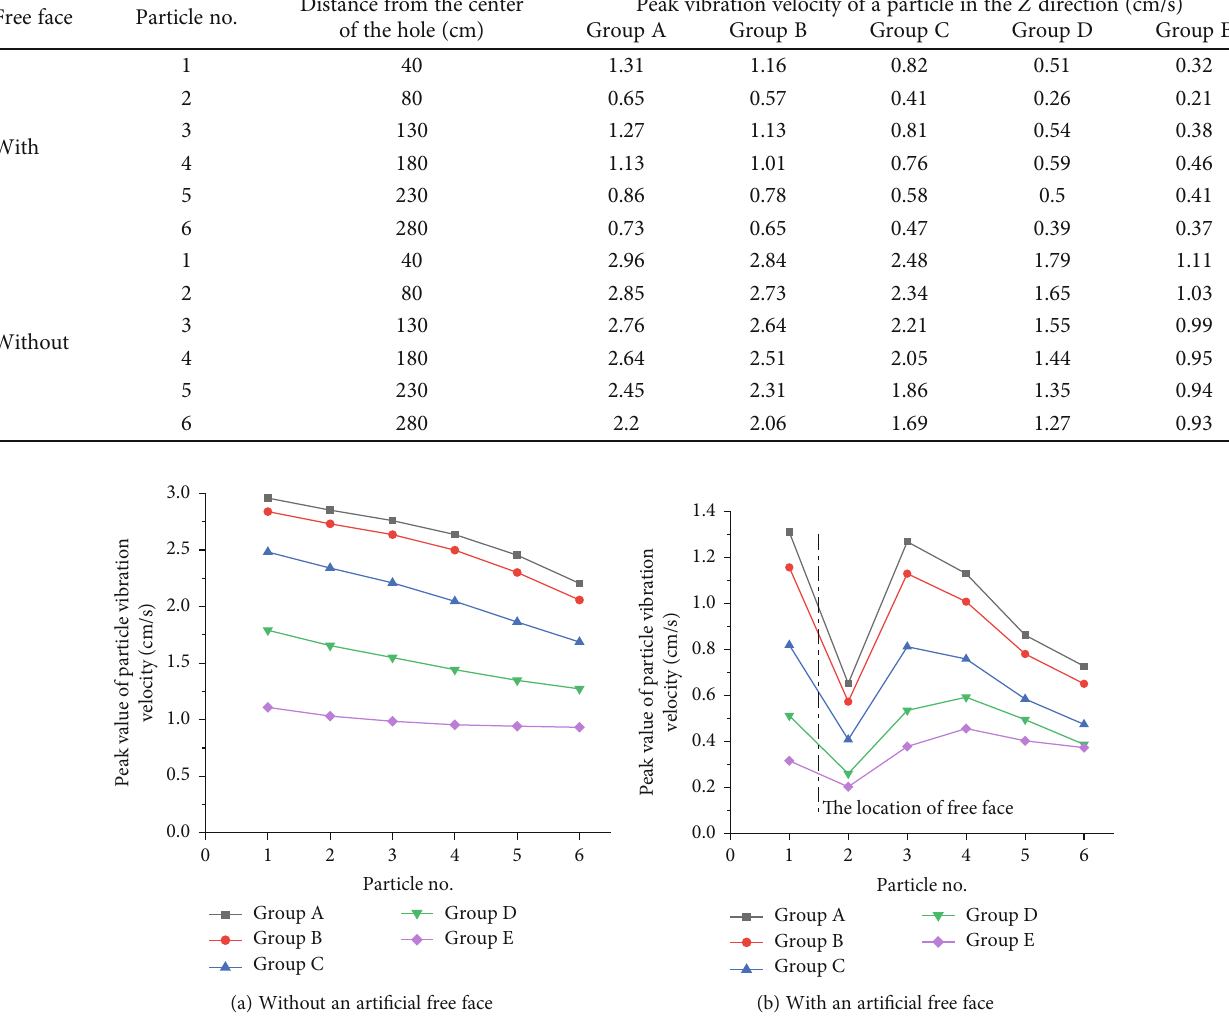
Figure 17: The peak vibration velocity curves of particles. Table 11: Decreasing degree of the peak vibration velocity of